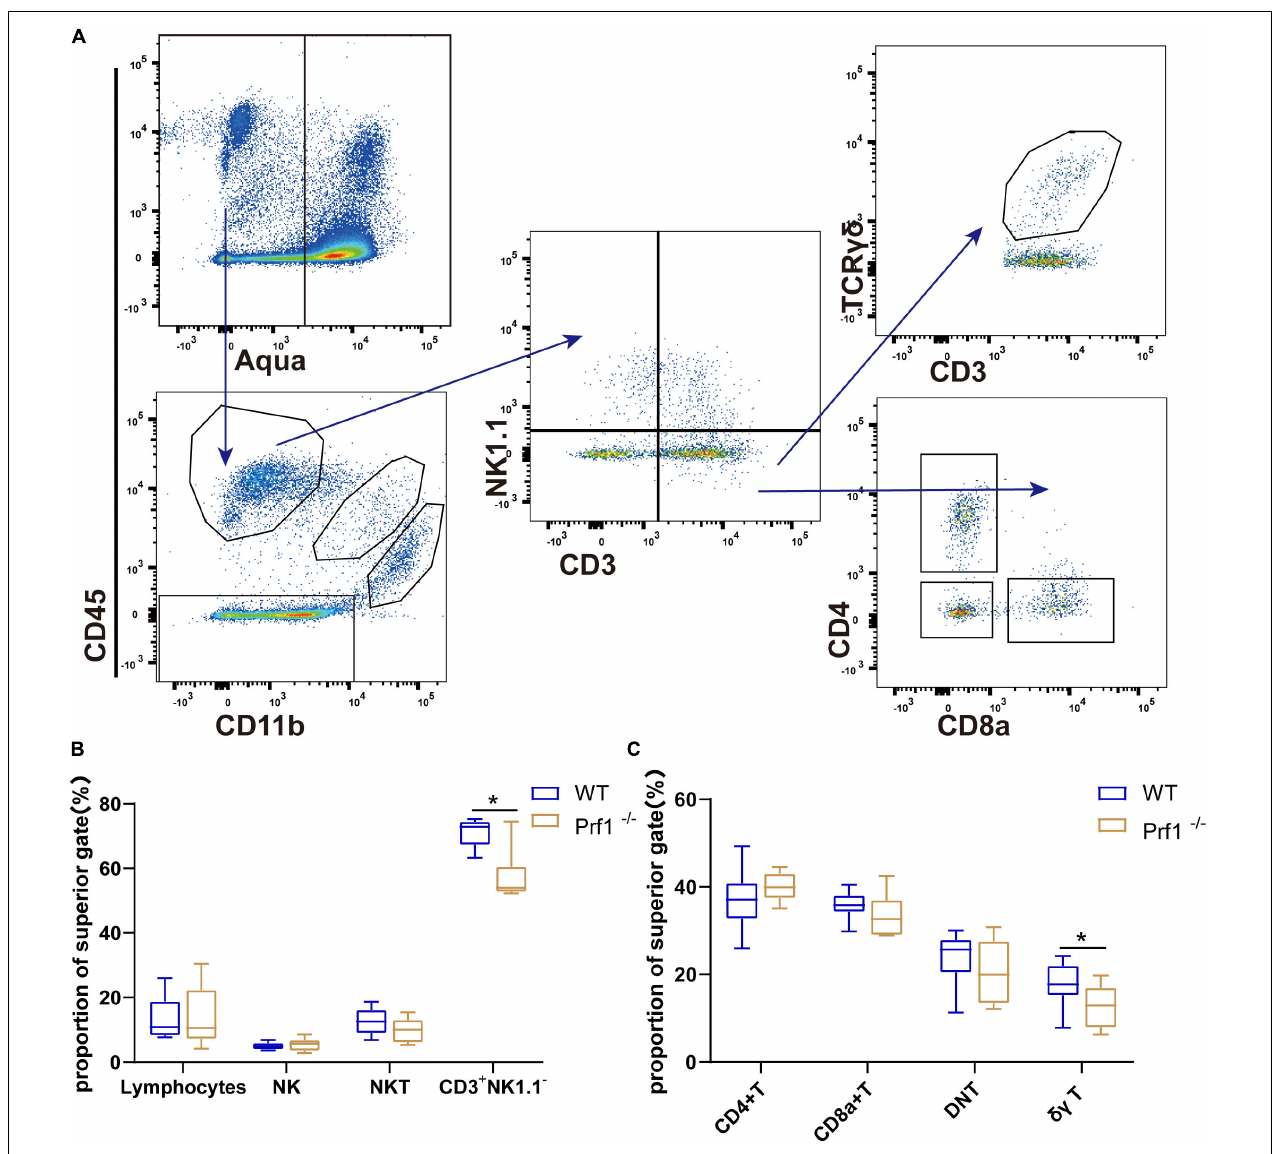
FIGURE 5 | Inhibition of perforin impairs the infiltration of CD3 + NK1.1 - T cells and γδ T cells. (A) Flow diagram showing various lymphocyte subtypes. Lymphocytes are Aqua - CD11b - CD45 + cells, and they can be divided into several cell subtypes according to the expression of classical markers, such as CD3, NK1.1, TCR γδ , CD4, and CD8. (B,C) The plot displays the proportions of these lymphocytes. The data are shown as the median and the value of min to max; n = (6–10) animals in each group. Prf1 - / - mice vs. WT mice at each time point. * P < 0.05, ** P <